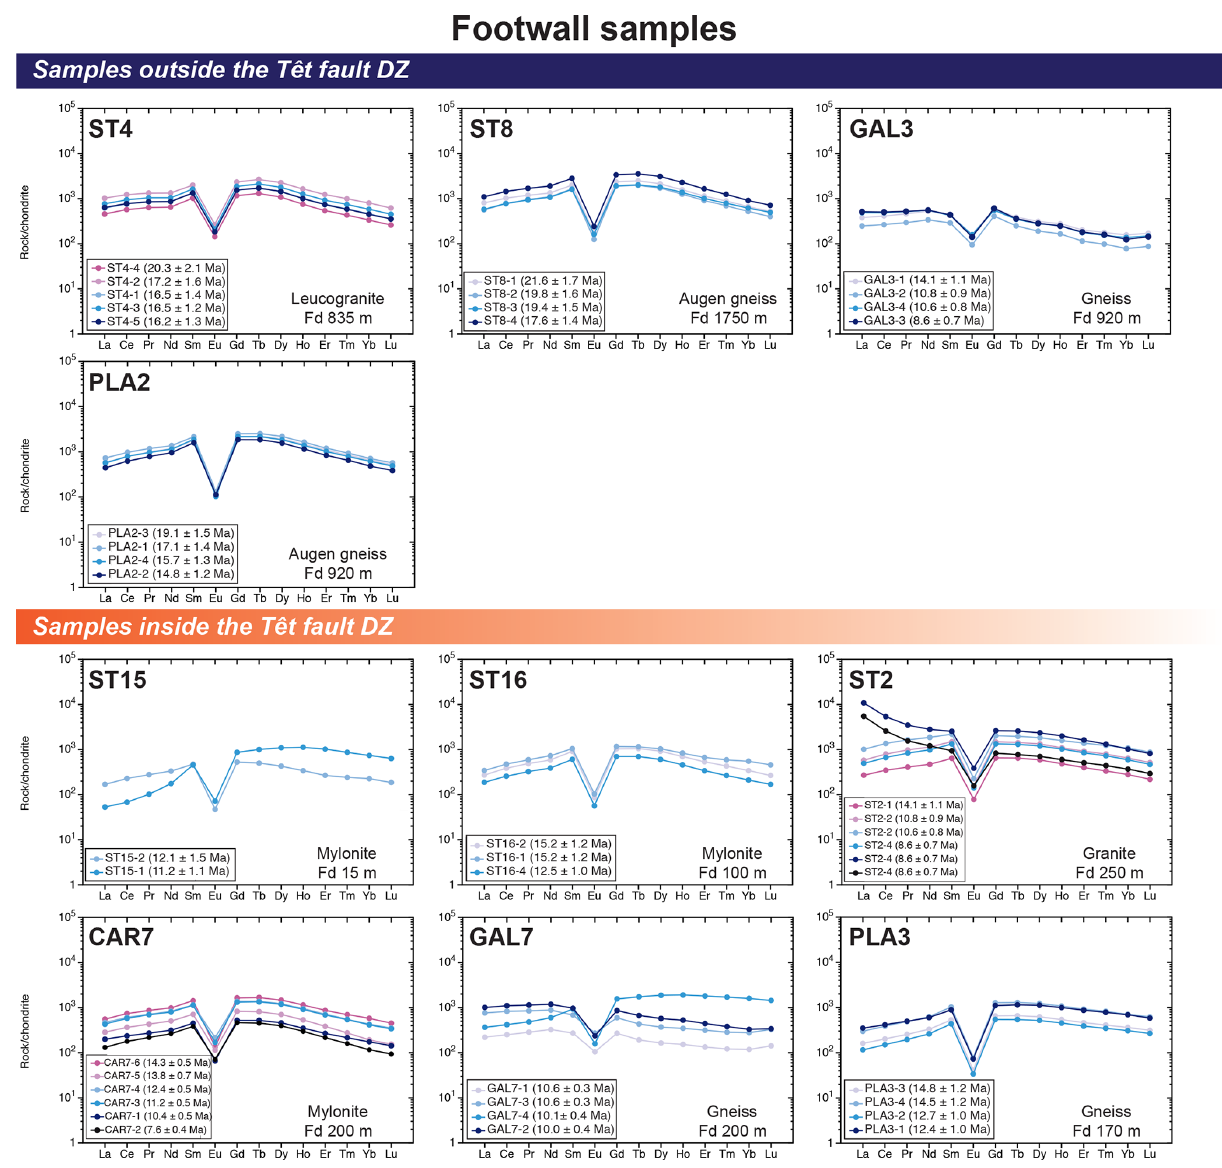
Figure 8. Chondrite-normalized REE patterns (Sun and McDonough, 1989) for the Têt fault footwall samples outside and inside the DZ. Fd: fault